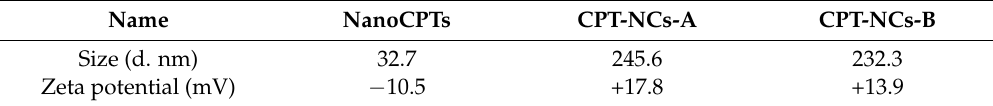
Table 1. Hydrodynamic sizes and zeta potentials of NanoCPTs and